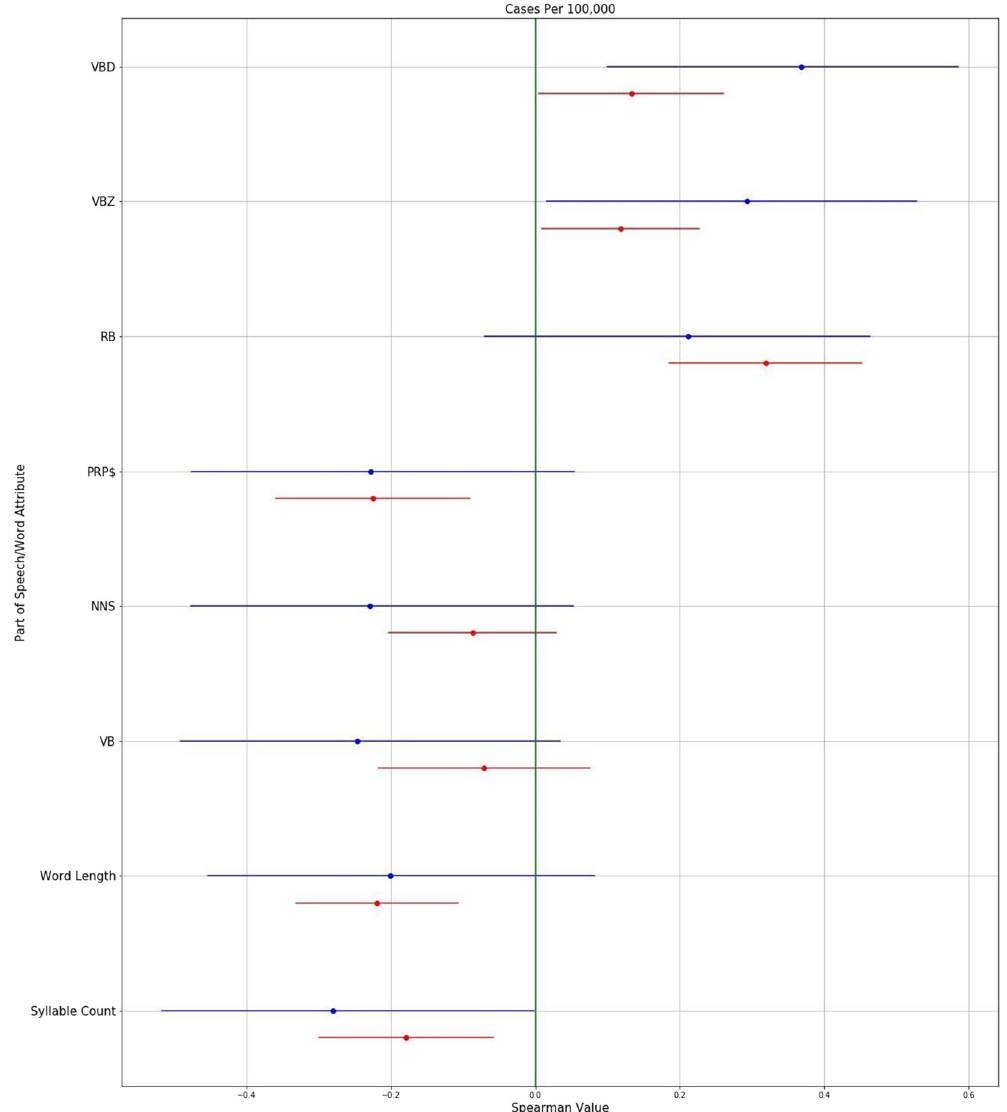
Fig. 4 Parts of Speech and linguistic complexity measures associated with COVID-19 case rates. Parts of speech and linguistic complexity measures associated with Covid-19 case rates over both space and time. Average Spearman Rho correlations with 95% con fi dence intervals, calculated over both space (blue) and time (red). (VBD: Verb, past tense; VBZ: Verb, present tense; RB: Adverb; PRP$: Pronoun, possessive; NNS: Noun, common, plural; VB: Verb, base